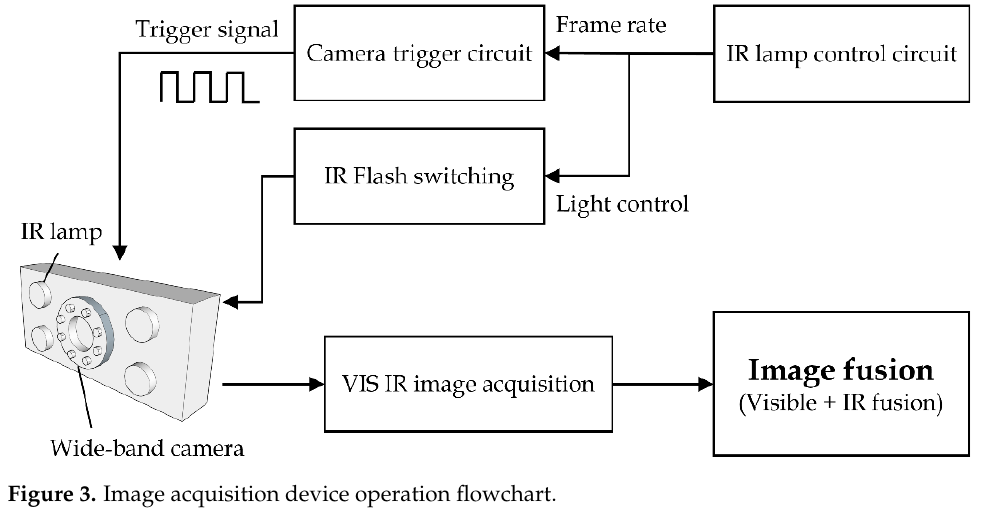
Figure 3. Image acquisition device operation flowchart.